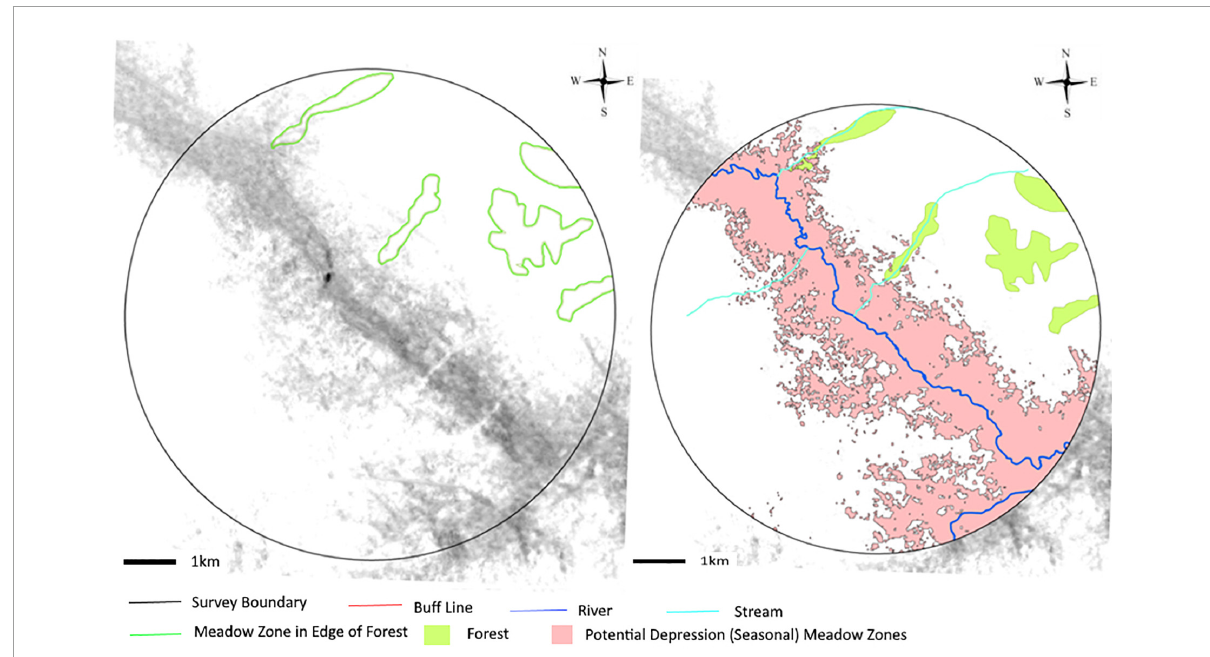
FIGURE9 (Left) Image showing the extended meadow zones along the forest in the 5 km radius survey area. (Right) Image showing the location of rivers, streams, forests, and the potential depression (seasonal) meadow zones within the 5 km radius survey area.